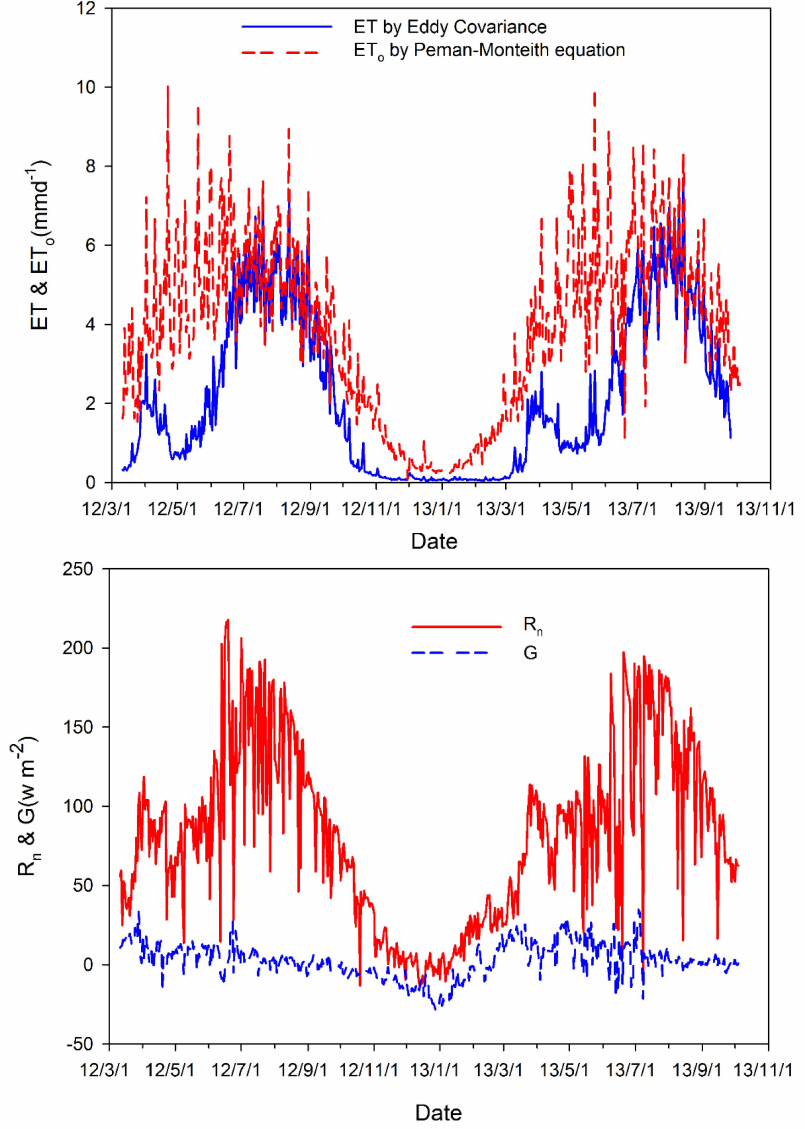
Figure 2. Evapotranspiration and energy flux measured by eddy